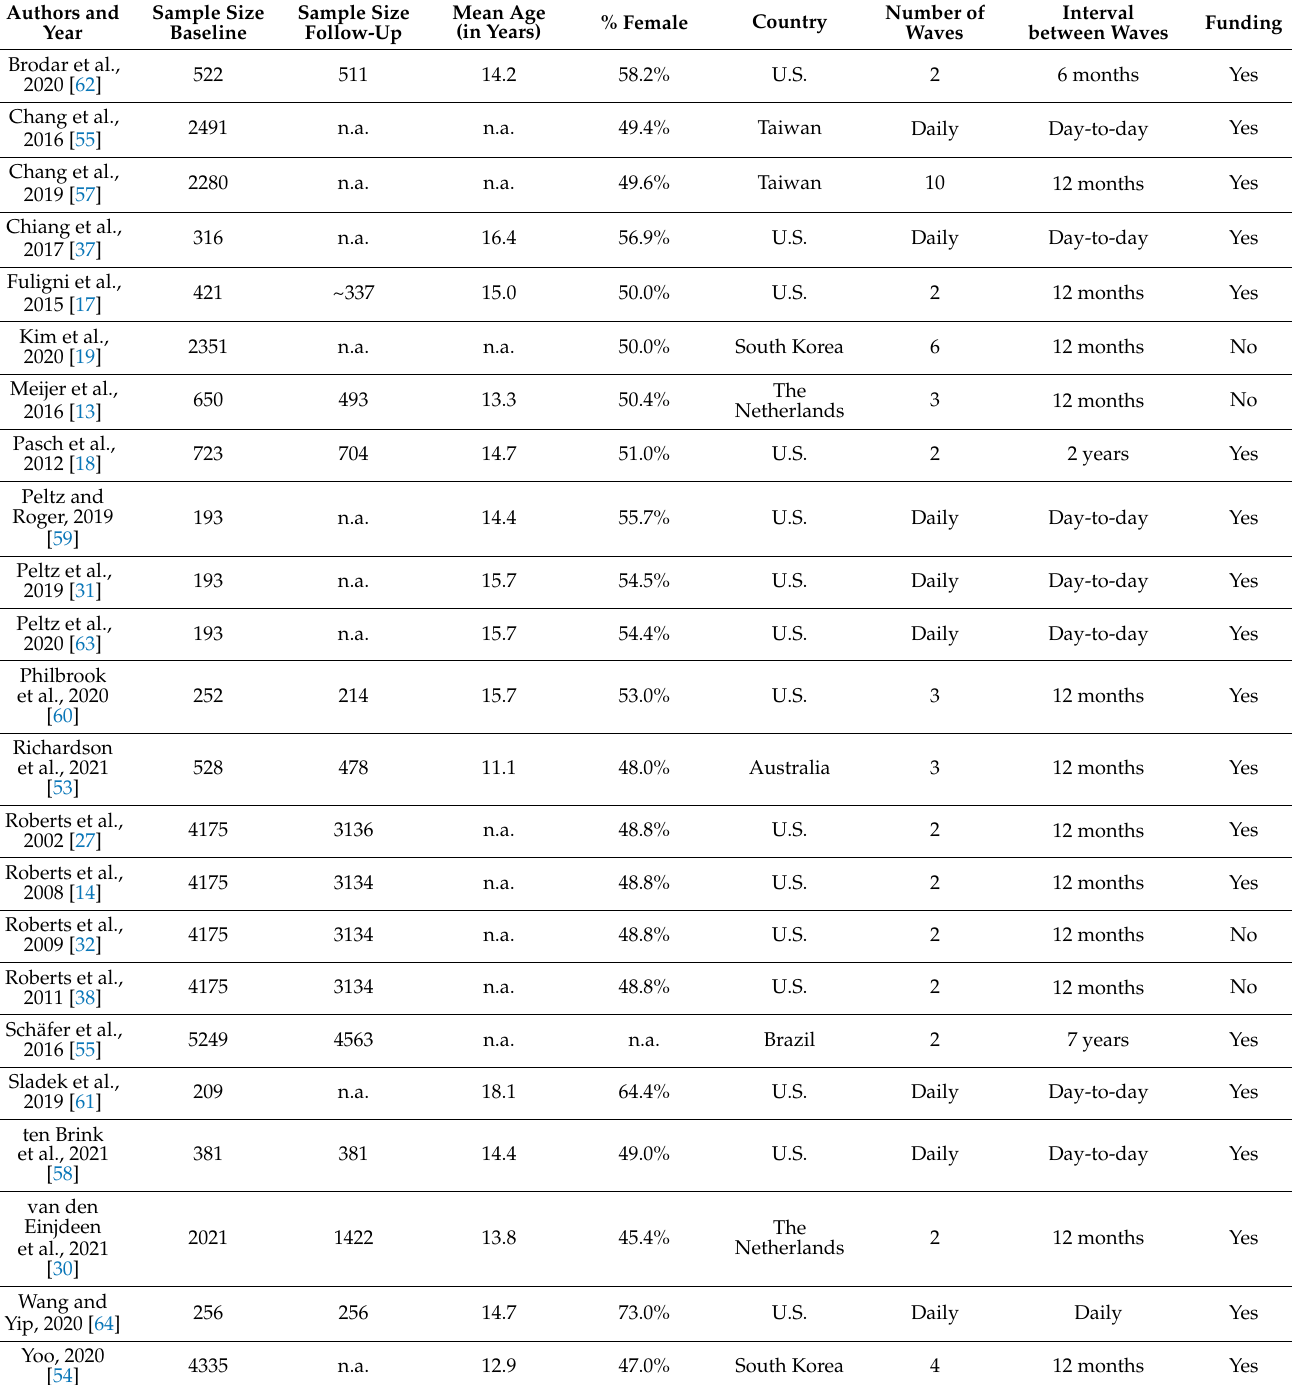
Table 1. Characteristics of Studies Included in the Systematic